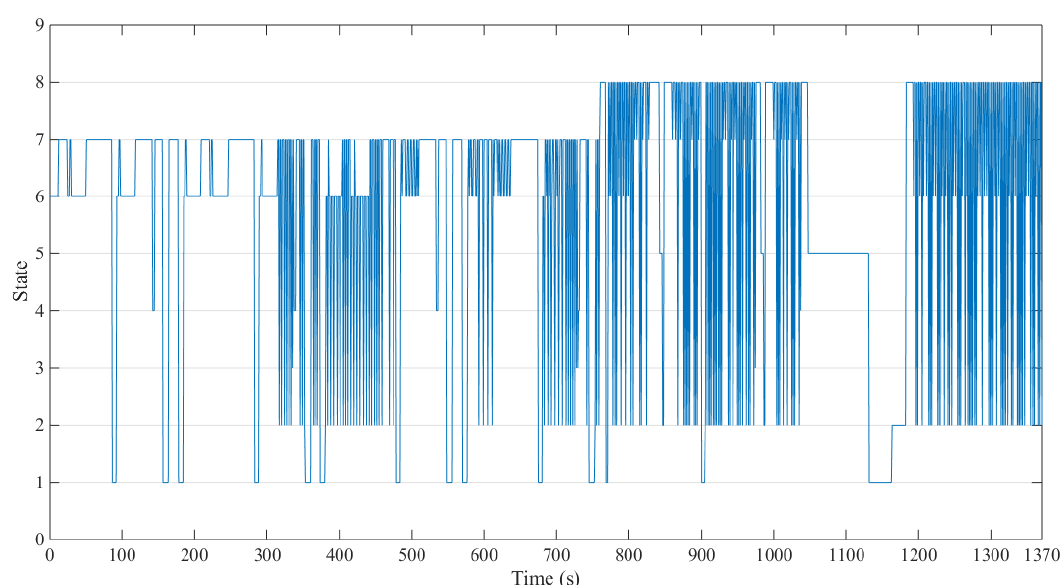
Figure 16. The current of working batteries. Energies 2020 , 13 , x FOR PEER REVIEW